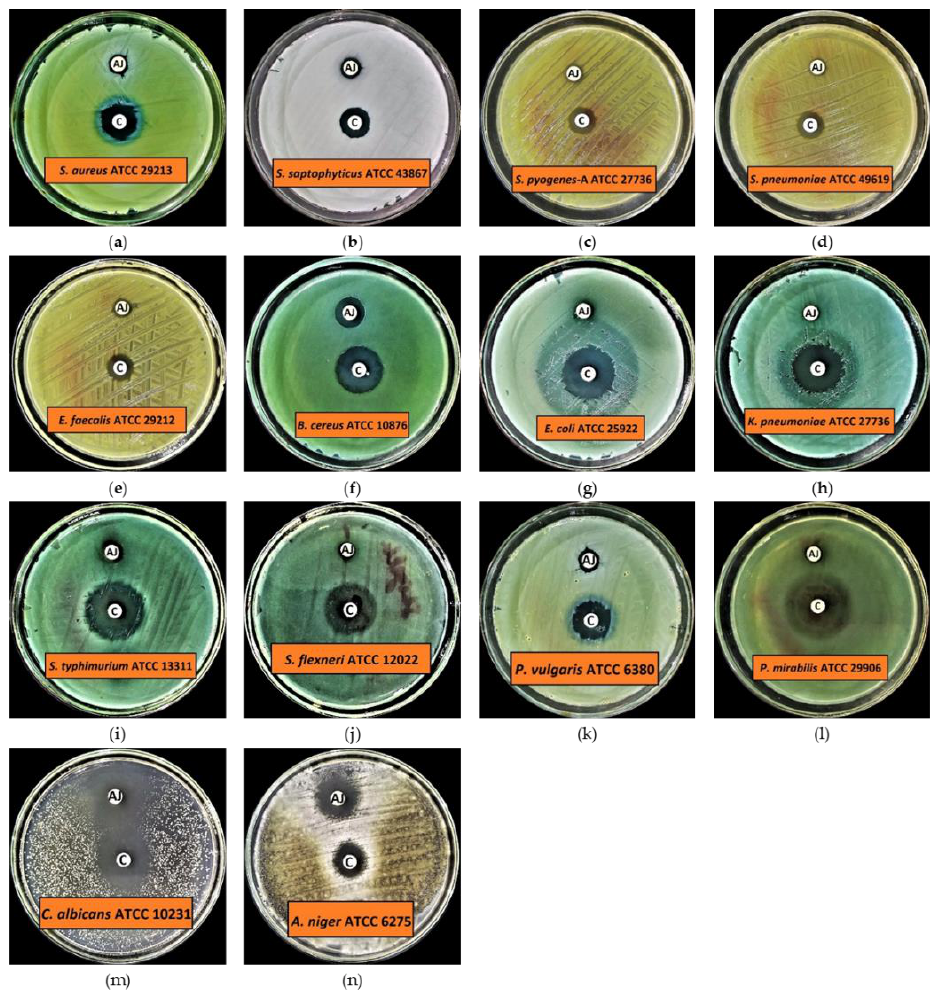
Figure 2. Preliminary antimicrobial activity of ArJ essential oil. ( a ) Staphylococcus aureus ( S. aureus ) ATCC 29213; ( b ) Staphylococcus saptophyticus ( S. saptophyticus ) ATCC 43867; ( c ) Streptococcus pyogenes ( S. pyogenes )-A ATCC 27736; ( d ) Streptococcus pneumoniae ( S. pneumoniae ) ATCC 49619; ( e ) Enterococcus faecalis ( E. faecalis ) ATCC 29212; ( f ) Bacillus cereus ( B. cereus ) ATCC 10876; ( g ) Escherichia coli ( E. coli ) ATCC 25922; ( h ) Klebsiella pneumonie ( K. pneumoniae ) ATCC 27736; ( i ) Salmonella typhi- murium ( S. typhimurium ) ATCC 13311; ( j ) Shigella flexneri ( S. flexneri ) ATCC 12022; ( k ) Proteus vul- garis ( P. vulgaris ) ATCC 6380; ( l ) Proteus mirabilis ( P. mirabilis ) ATCC 29906; ( m ) Candida albicans ( C. albicans ) ATCC 10231; ( n ) Aspergillus niger ( A. niger ) ATCC 6275. Table 3. Preliminary antimicrobial activity of ArJ essential oil. Microorganisms Zone of Inhibition (mm) ArJ Essential Oil